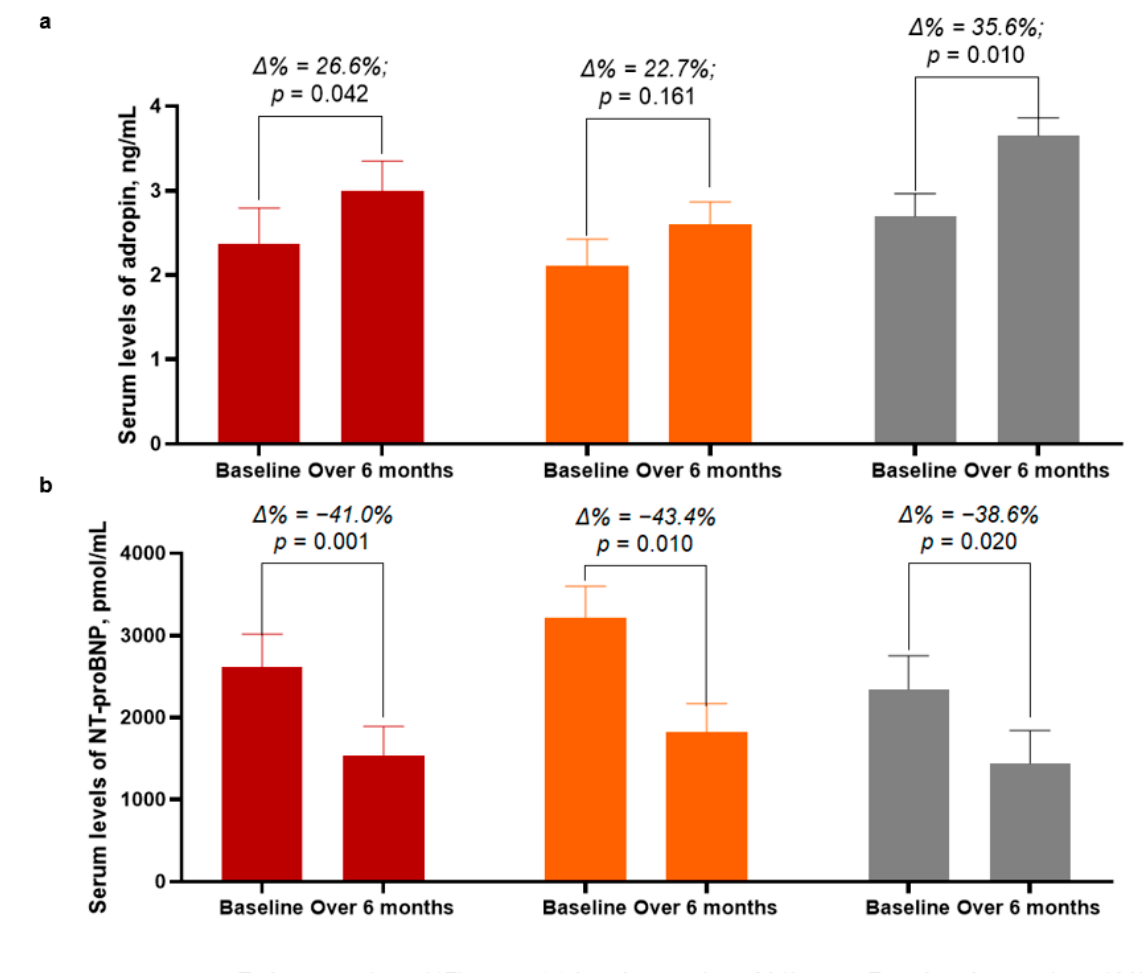
Figure 2. Bar graphs at baseline and 6 months after administration of SGLT2 inhibitor dapagliflozin, showing dynamics of serum levels of adropin ( a ) and NT-proBNP ( b ). Abbreviations: ∆ %, respective percentage of changes of parameters.